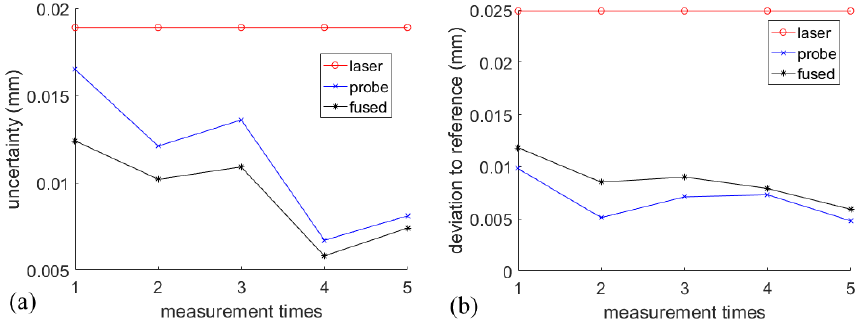
Figure 27. Repeated measurement result for: ( a ) uncertainty; and ( b ) deviation from the reference surface.